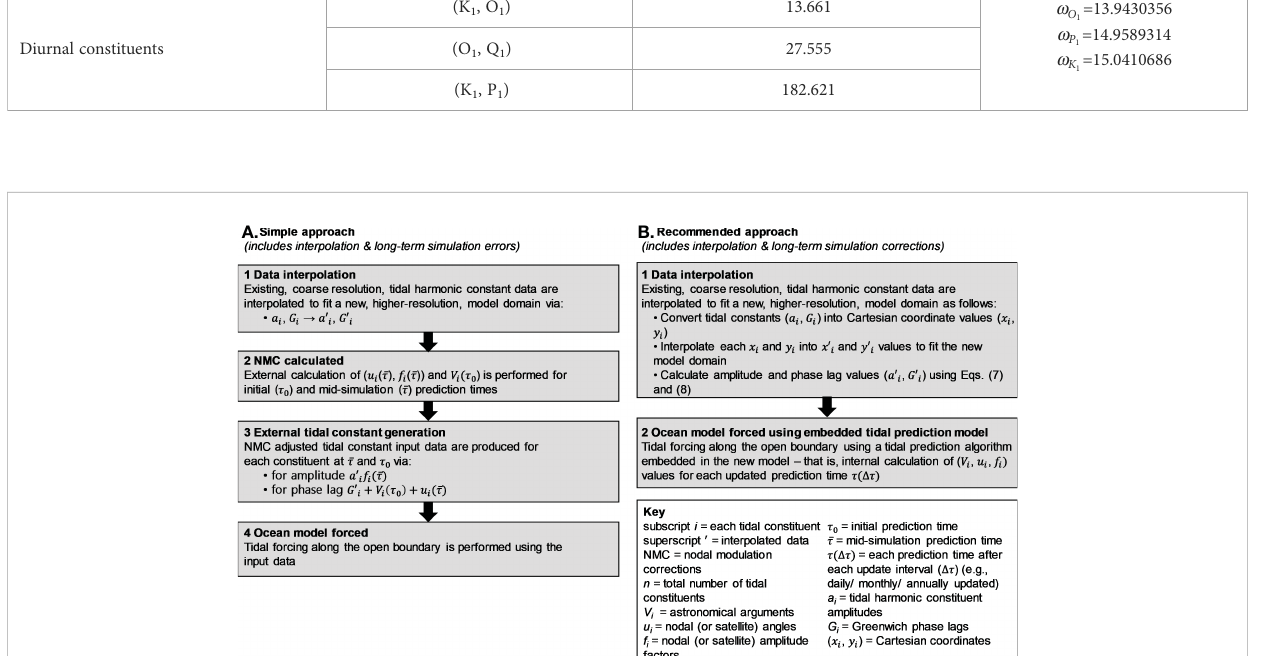
FIGURE 6 Comparison of (A) simple (error prone) and (B) improved alternative (standard harmonic prediction based) methodological procedures for generating the tidal forcings fi le needed to predict tides in regional and coastal ocean models.